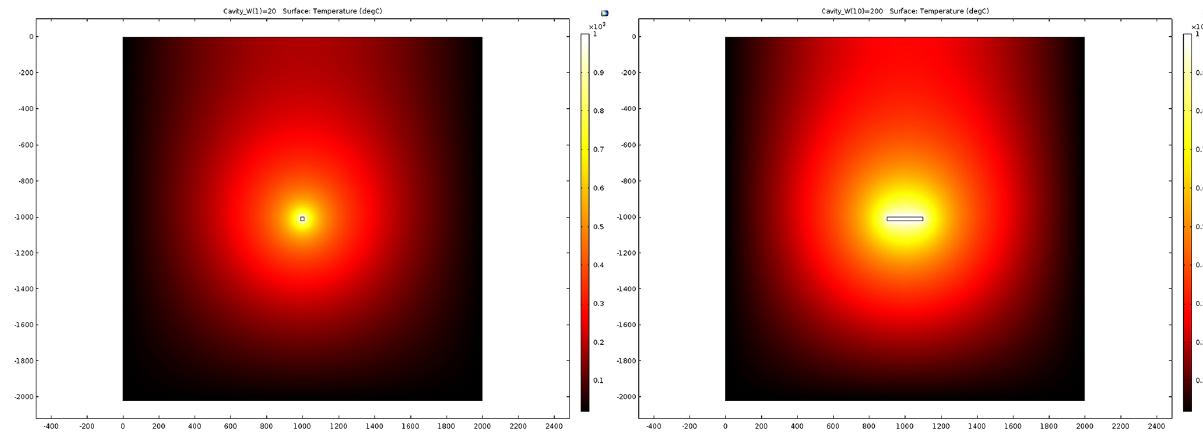
Figure 15. Temperature distribution around a deep seated